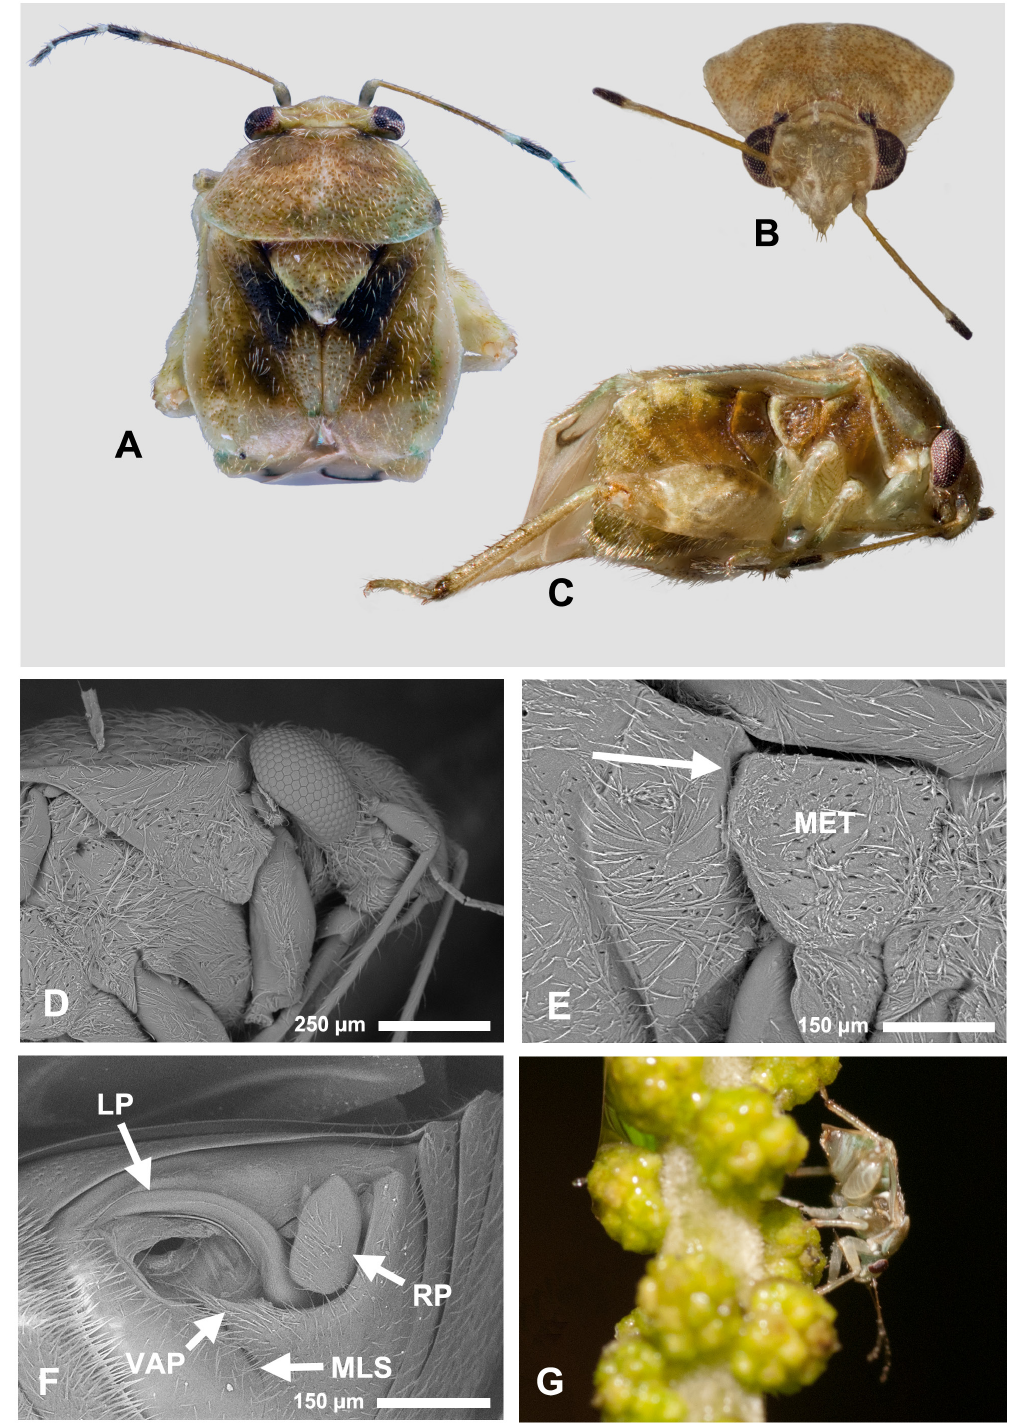
Fig. 4. Photographs and scanning electron micrographs of Coridromius mulu sp. nov. A . Dorsal habitus, ♂. B . Head and pronotum, anterior view, ♂. C . Lateral view, ♀. D . Head and thorax, lateral view. E . Metathorax and anterior of abdomen of ♀, lateral view; arrow indicates site of insemination. F . ♂ genitalia. G . Photograph of ♂ on unidentified species of Homalanthus . LP = left paramere, MET = metathoracic lobe, MLs = mesal longitudinal suture of pygophore, rP = right paramere, VaP = ventral apical process of